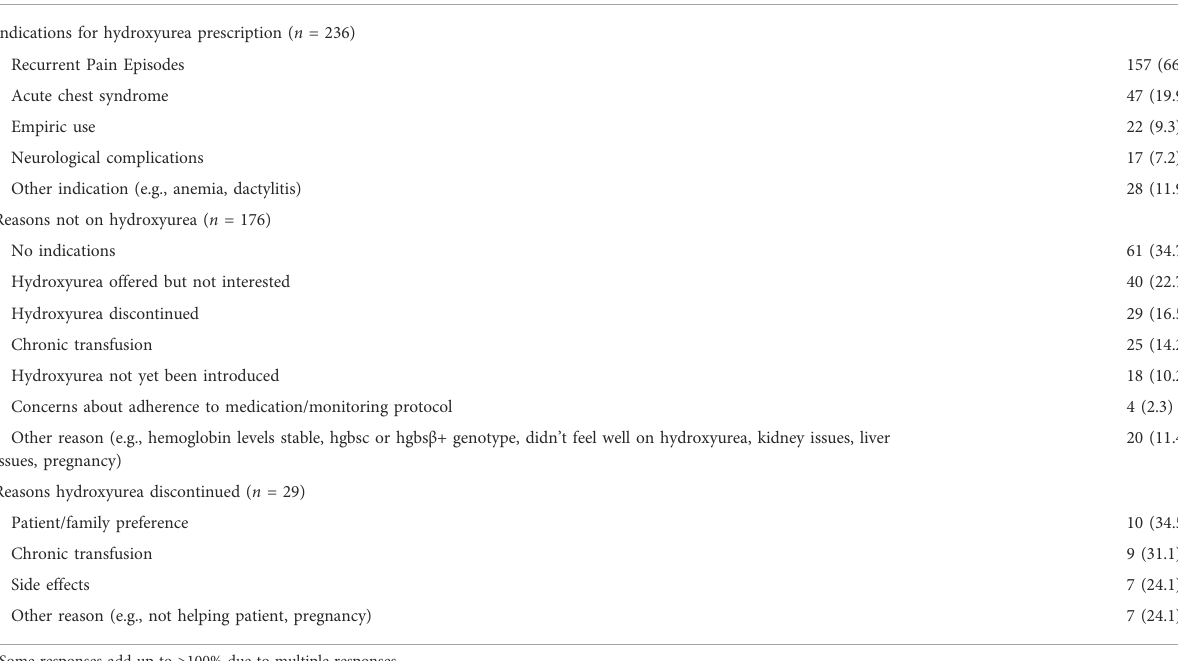
TABLE 3 Provider-reported indications & reasons for hydroxyurea prescription a .